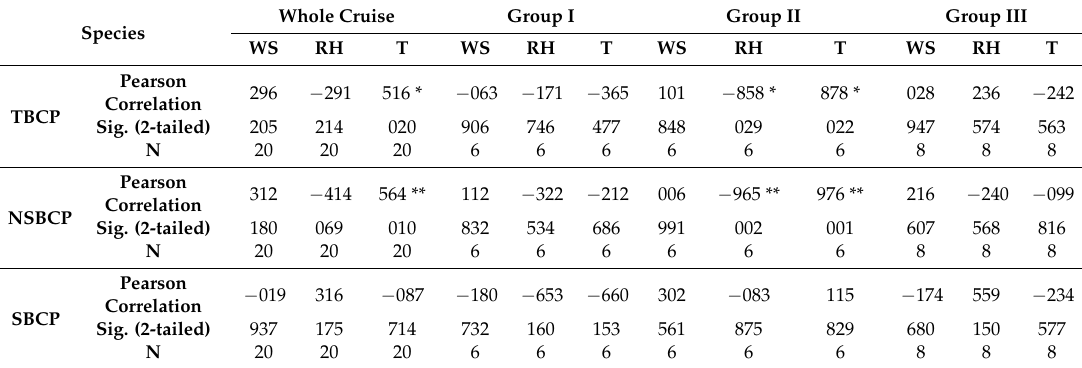
Table 2. Correlation of bacteria-containing particles (BCPs) with wind speed (WS), relative humidity (RH), and temperature